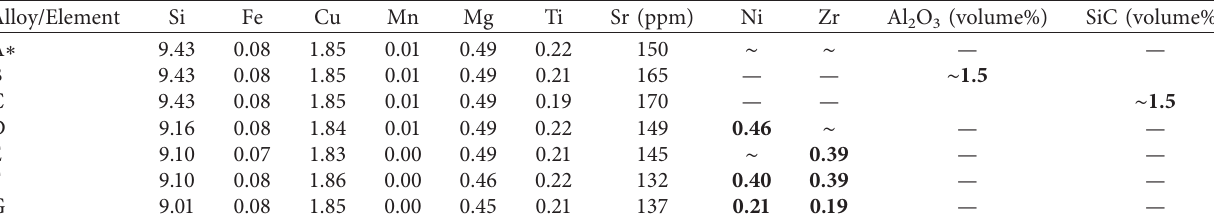
Table 2: Chemical composition of the 354 alloys used in this study (wt.%). Alloy/Element